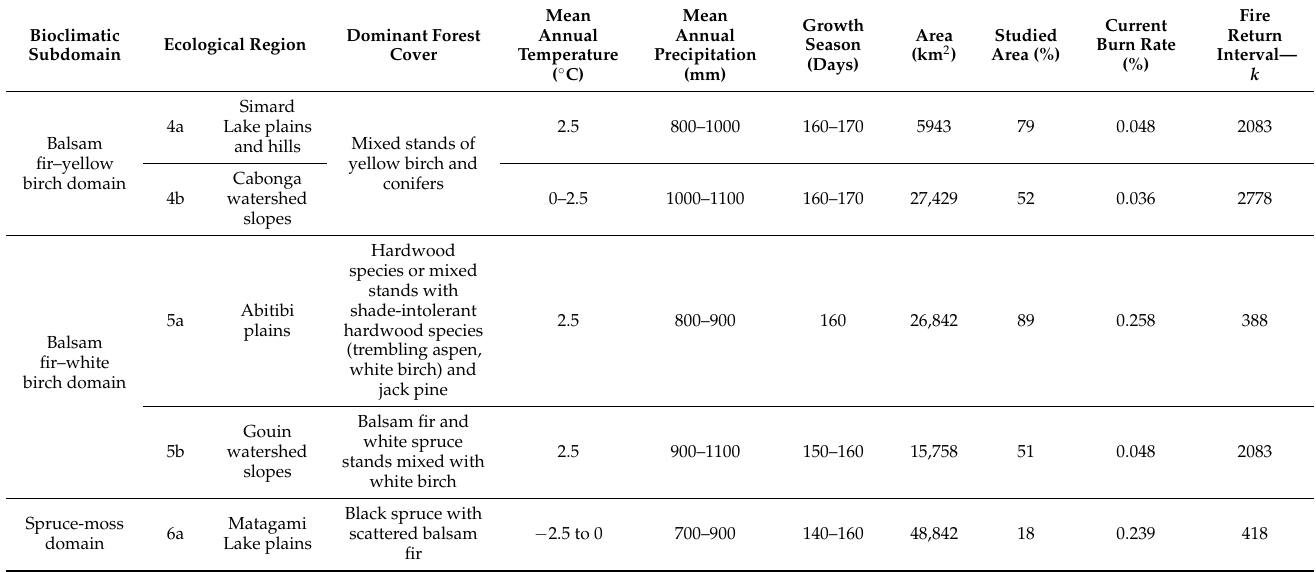
Table 1. Characteristics and fire regime of the ecoregions within the study area in the Boreal Forest of